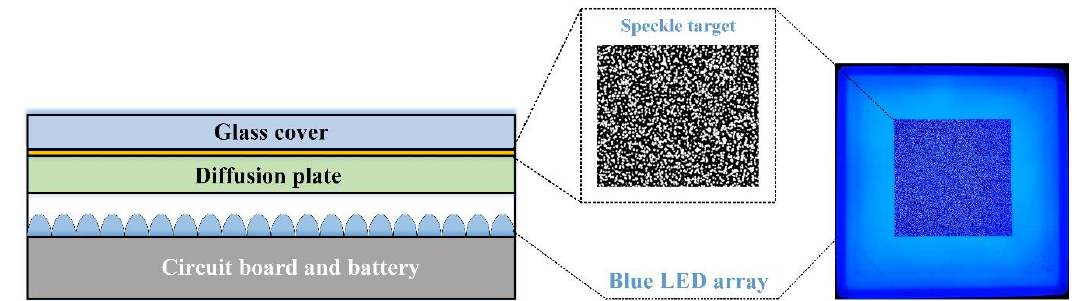
Figure 2. The schematic (left) and photograph (right) of the backlight digital speckle target. It consists of 5 layers—i.e., battery and circuit board layer (wireless power supply), blue LED array layer (high illuminance panel light source), diffusion plate layer (backlight homogenization), digital speckle pattern layer (blocking/transmitting backlight for high-contrast speckle pattern formation), and glass cover layer (protection).